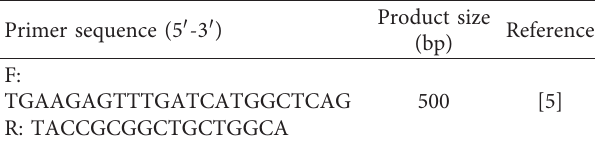
Table 1: Primer set used for PCR. Primer sequence (5 ′ -3 ′